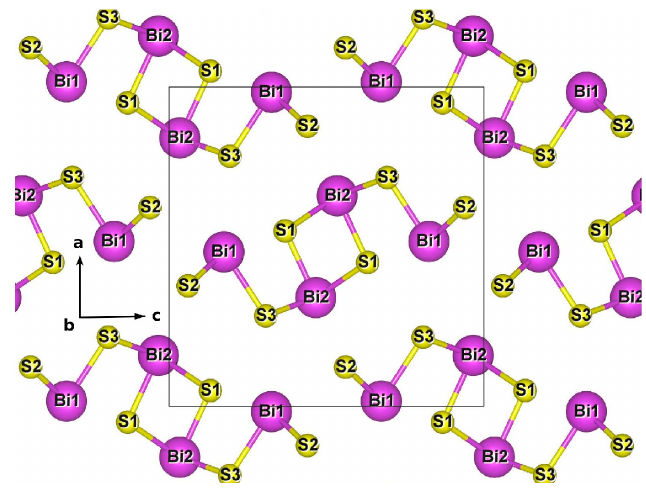
Figure 4. Crystal structure of bulk Bi 2 S 3 , at zero pressure, showing the unit cell. Table 1. Calculated zero pressure lattice parameters and unit cell volumes for bulk Bi 2 S 3 , Fe-doped Bi 2 S 3 at Bi1 and at Bi2 sites. Experimental data for bulk Bi 2 S 3 at zero pressure was taken from Ref. [26]. For all the structures, α = β = γ = 90°.